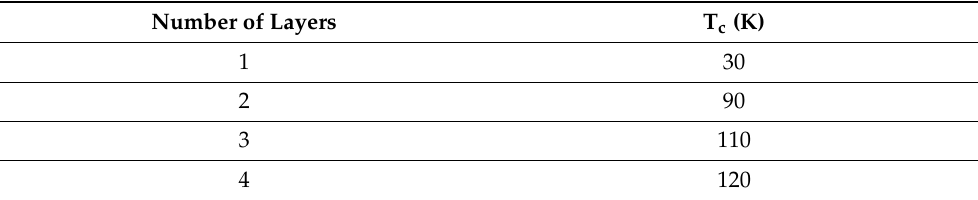
Table 3. Superconductivity correlated with the number of Cu–O